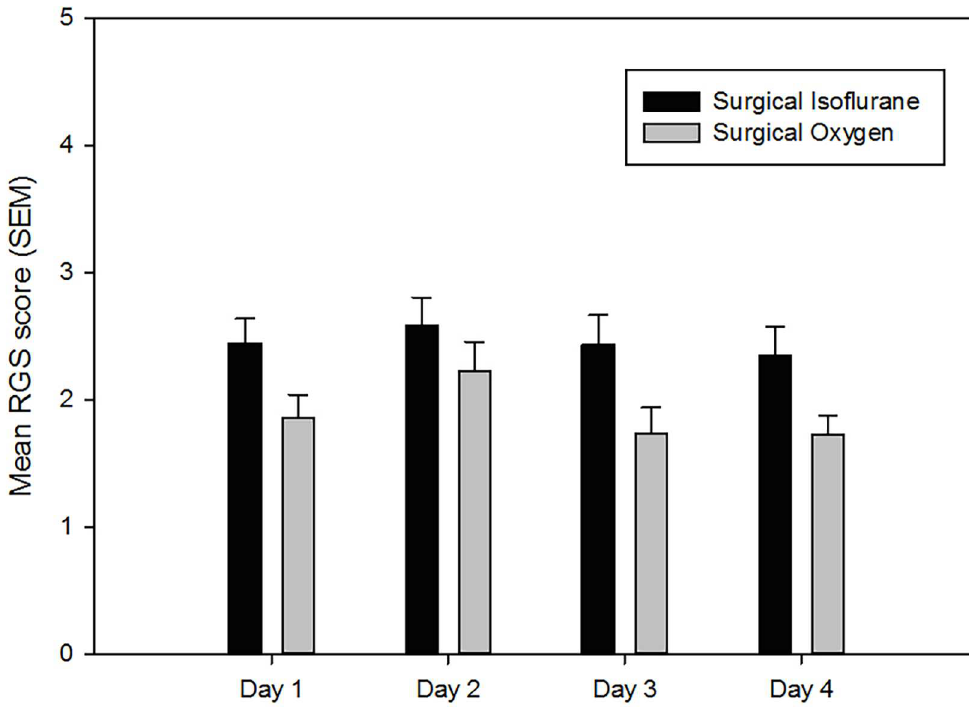
Fig 2. Mean rat grimace scale score ( ± SEM) for animals in the surgical duration isoflurane and oxygen groups on 4 consecutive days. Maximum score 8.